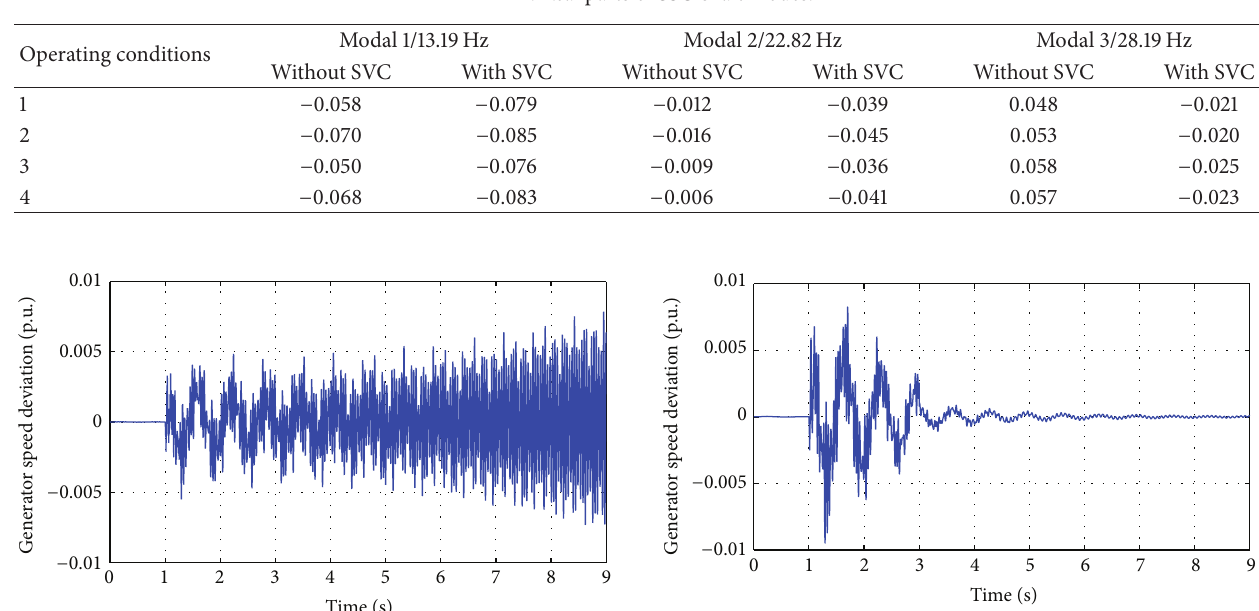
Table 1: Real parts of SSO shaft modes.